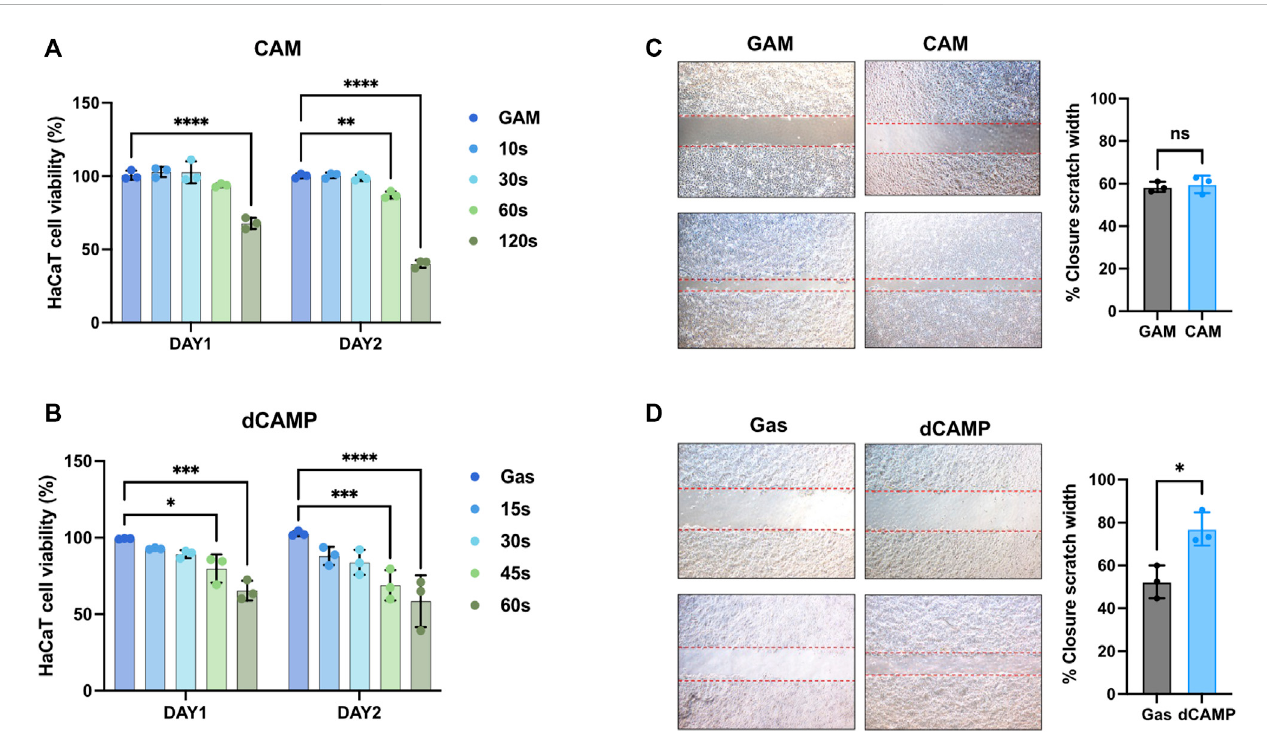
mRNA expression was measured using qRT-PCR. SYBR Green reagents (PowerUp SYBR Green Master Mix, A25741,